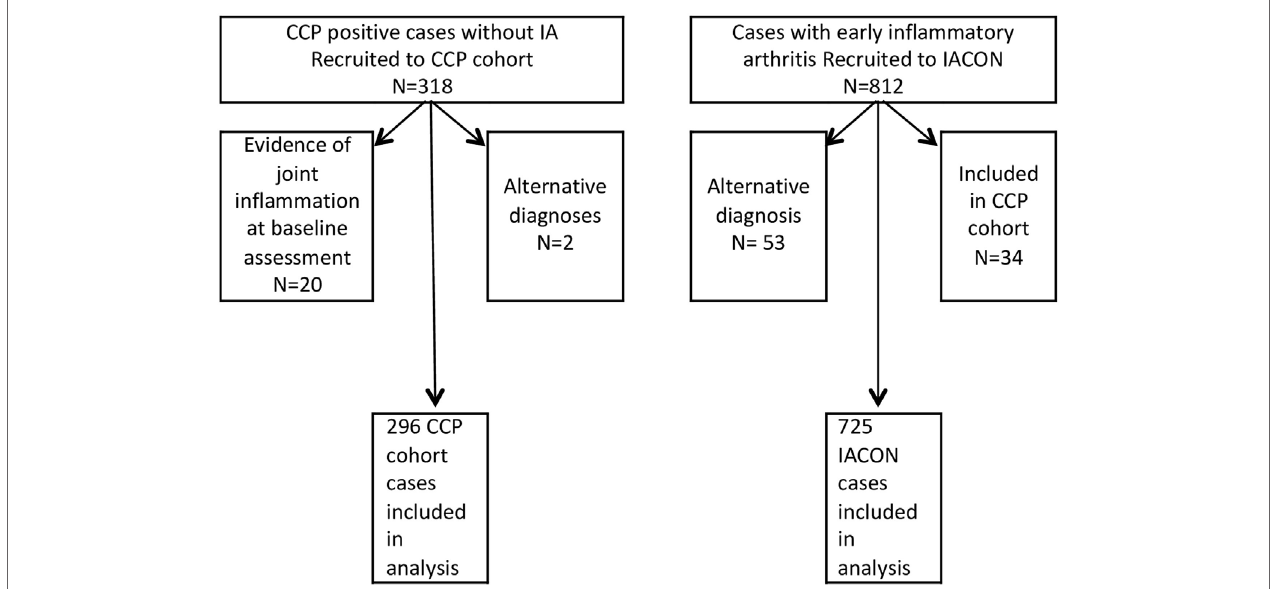
FigUre 1 | Diagram to show how numbers of cases were derived from each